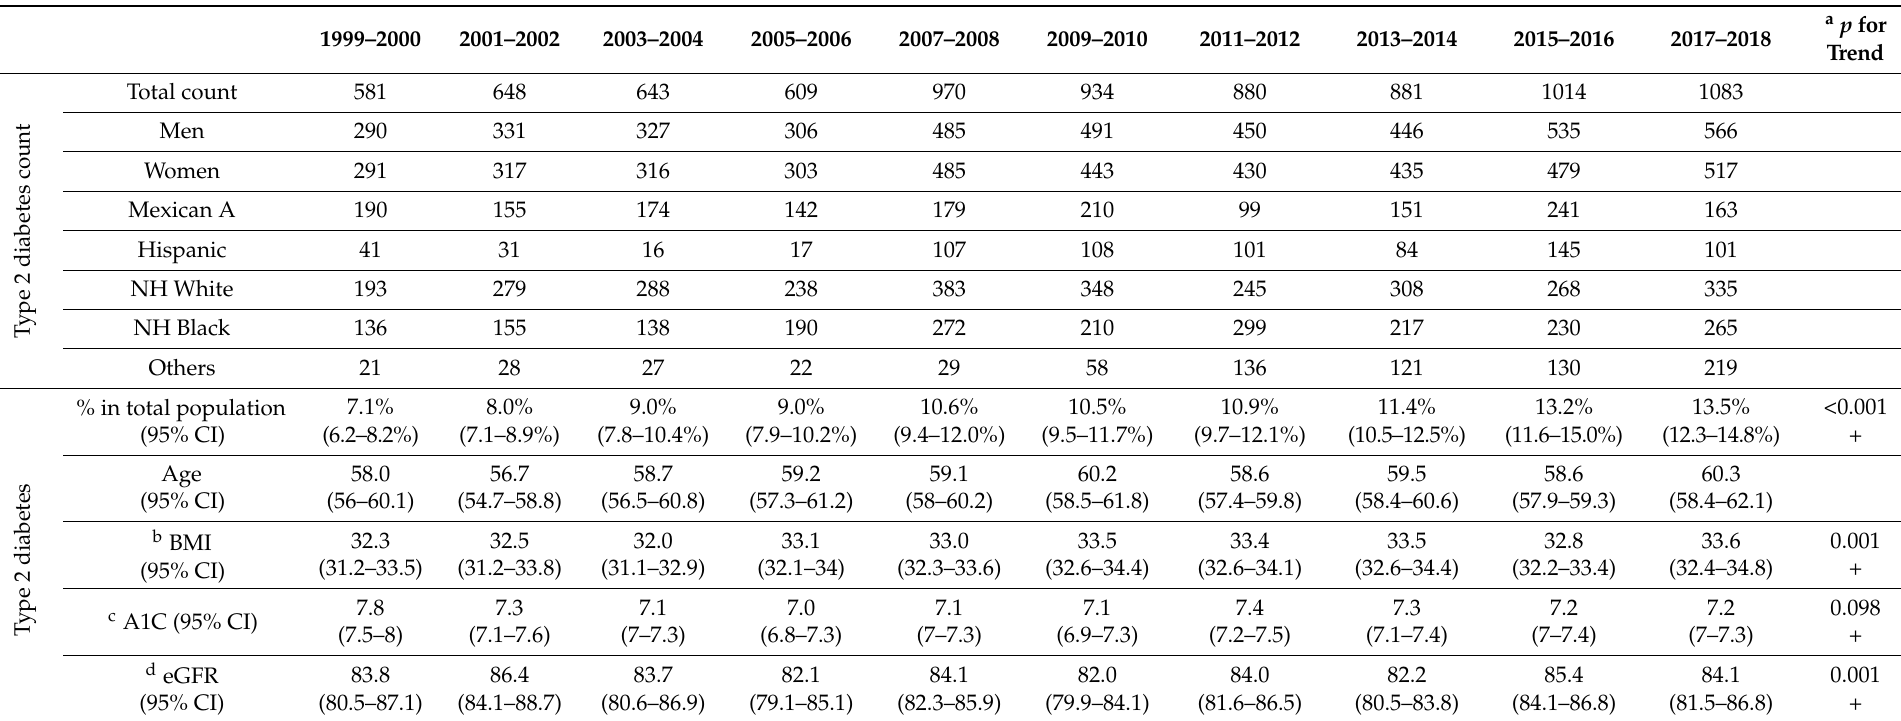
Table 1. Demographic data and population means of BMI, A1c, and